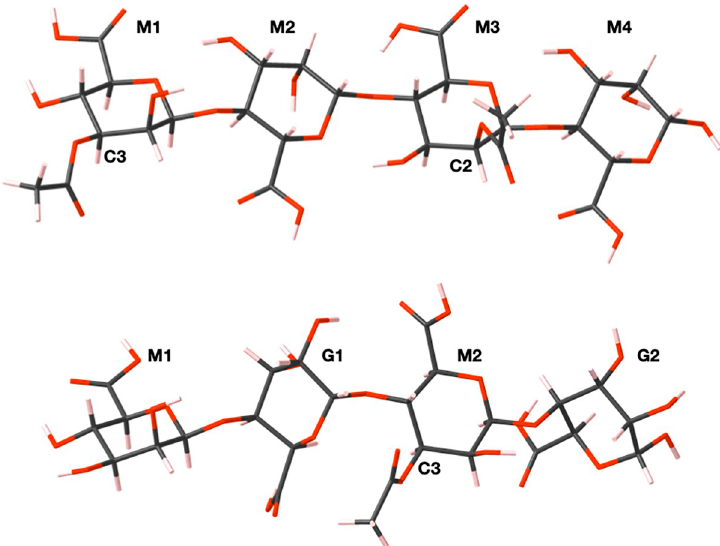
Fig 1. Examples of thermodynamically stable (top) acetylated poly- β -D-mannuronate (PolyM) configuration and (bottom) the copolymeric β -D-mannuronate- α -L-guluronate (PolyMG) configurations. Carbon atoms are shown in grey, oxygen in red and hydrogen in pink. The uronate units and acetylated carbon atom positions are labelled for clarity.